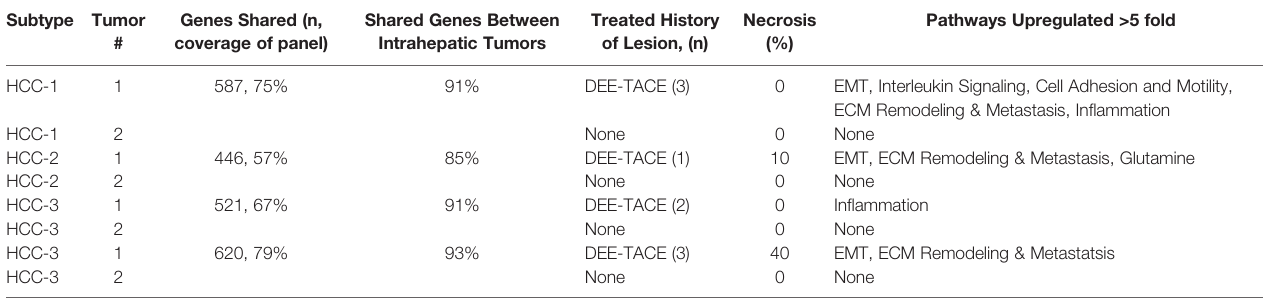
TABLE 8 | Shared gene expression within multifocal HCC on explant. Subtype Tumor Genes Shared (n, # coverage of